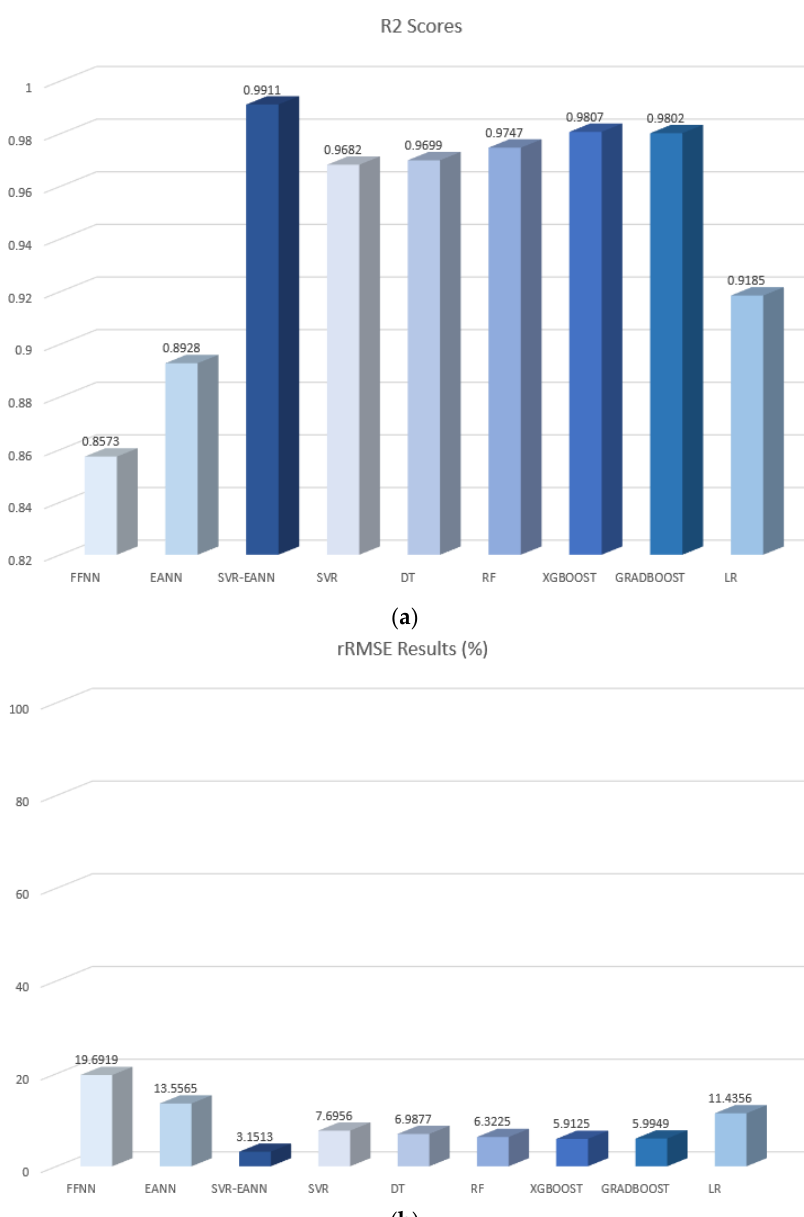
Figure 7. Visualization of the results obtained in this study, ( a ) R 2 scores, and ( b ) rRMSE results.